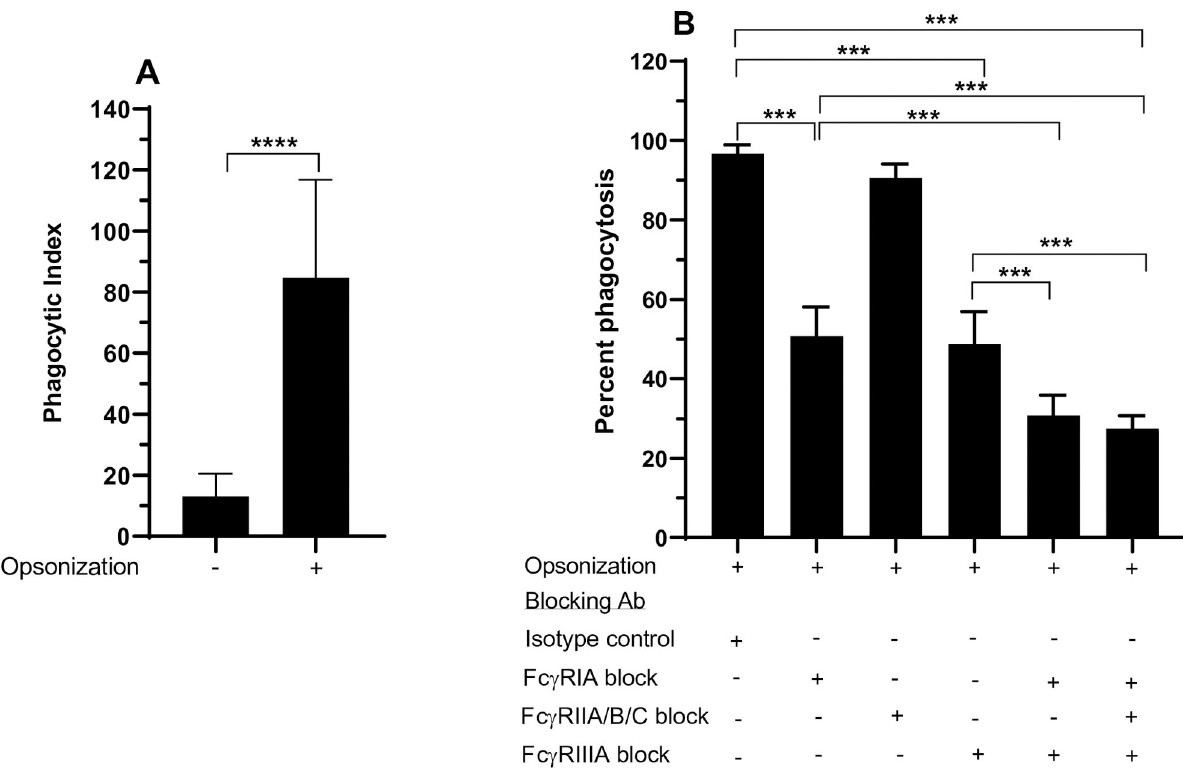
Fig 7. Fc γ R utilization by THP-1-CD16A cells in the phagocytosis of IgG-opsonized human platelets. THP-1-CD16A cells were differentiated to macrophages by treatment with PMA (100 ng/mL) as described in the Materials and methods. (A) Magnitude of macrophage phagocytosis of IgG- opsonized platelets. Opsonization: (-) indicates platelets were non-opsonized (incubated with normal human serum), (+) indicates platelets were opsonized with the monoclonal antibody A2A9 (5 μ g/mL). The phagocytic index was calculated as the number of platelets engulfed per 100 macrophages. Data are presented as the mean ± the standard deviation of eight independent experiments. The statistical analysis was performed by the non-parametric Mann-Whitney T-test ( ���� : p < 0.0001). (B) The contribution of each Fc γ R to the phagocytosis was evaluated using Fc region deglycosylated blocking antibodies (final concentration of 10 μ g/mL each): anti-Fc γ RI (clone 10.1), anti-Fc γ RIIA/B/C (clone AT10), or anti-Fc γ RIIIA (clone 3G8). The deglycosylated mouse IgG1 (clone MOPC-21) was used as isotype control (final concentration of 10 μ g/mL). Percent phagocytosis was assessed relative to macrophages without any antibody treatment of the THP-1-CD16A cells. Data are presented as the mean ± the standard deviation of five independent experiments. The statistical analysis was performed with a one-way analysis of variance (ANOVA) and Tukey’s multiple comparisons test ( ��� : p <